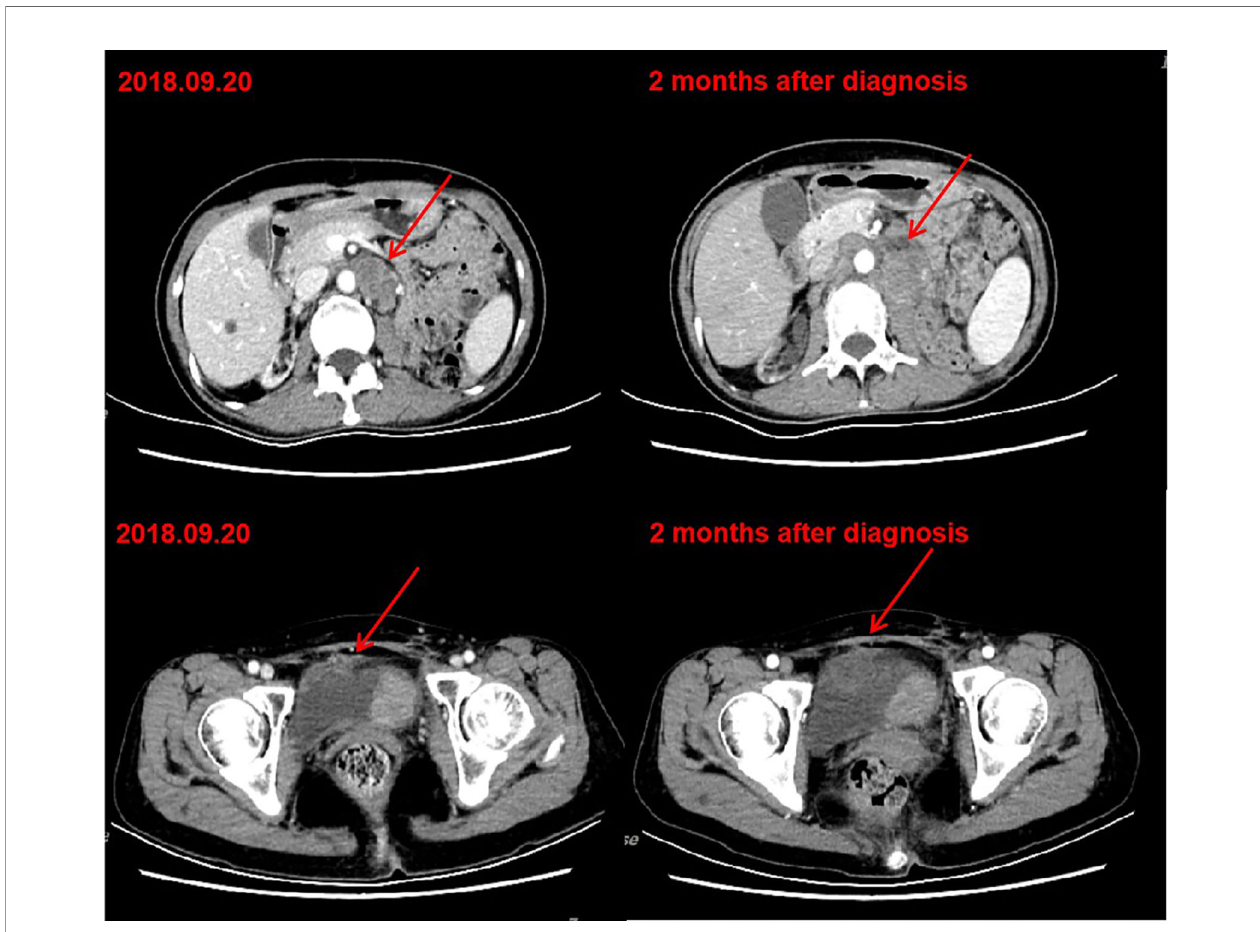
FIGURE 1 | CT after chemotherapy indicated tumor progression. Left: CT of September 20, 2018. Bladder cancer with retroperitoneal and pelvic lymph node metastasis. Right: CT of November 12, 2018. After two cycles of gemcitabine chemotherapy, retroperitoneal and pelvic lesions